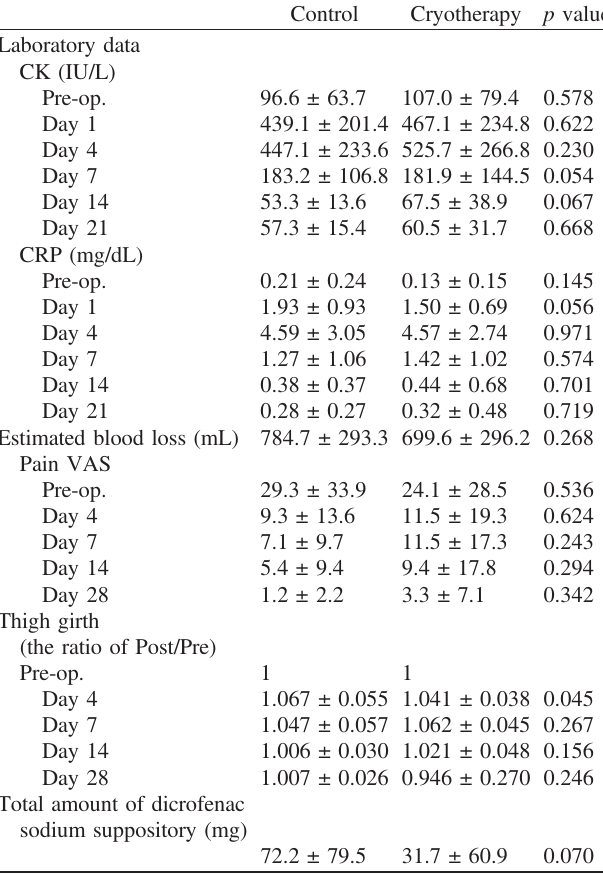
Table 2. Primary outcomes.